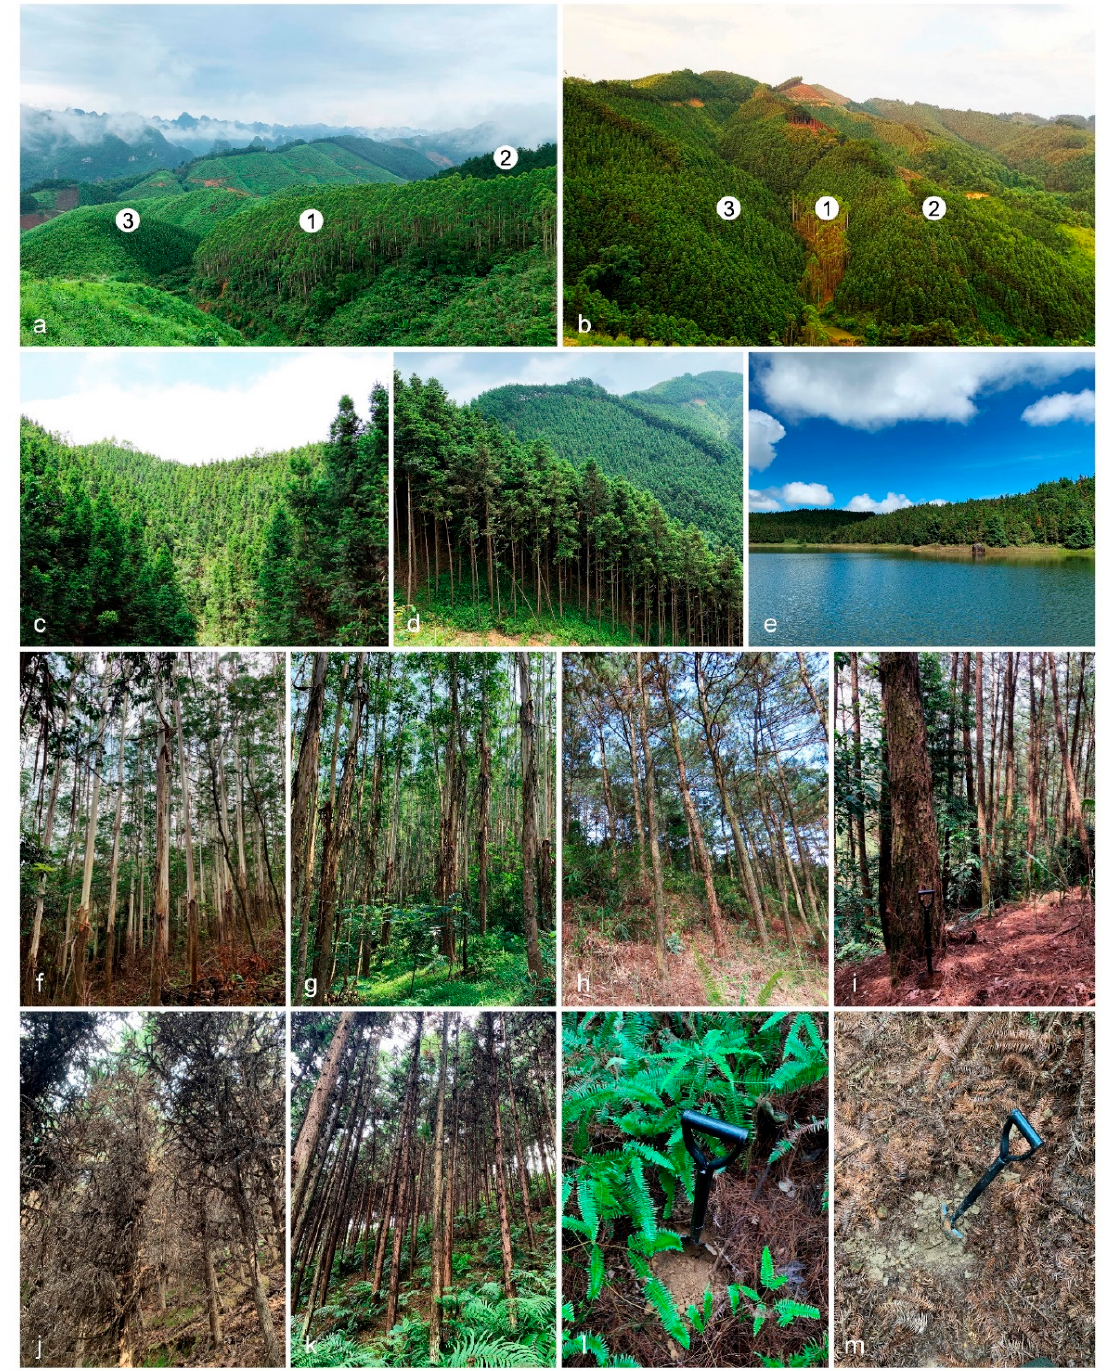
Figure 1. Plantations of Eucalyptus urophylla × E . grandis , Pinus massoniana , and Cunninghamia lanceolata in Fujian, Guangdong, Guangxi, and Yunnan Provinces in southern China. ( a , b ). The adjacently planted E . urophylla × E . grandis (indicated by number “1”), P . massoniana (number “2”), and C . lanceolata (number “3”) in Guangxi; c – e . Cunninghamia lanceolata plantations in Guangdong ( c ), Guangxi ( d ), and Yunnan ( e ); ( f , g ). Eucalyptus urophylla × E. grandis plantations in Fujian ( f ) and Guangdong ( g ); ( h , i ). Pinus massoniana plantations in Fujian ( h ) and Guangxi ( i ); ( j , k ). Cunninghamia lanceolata plantations in Fujian ( j ) and Guangxi ( k ); ( l ). Soil in P . massoniana plantation in Guangxi; ( m ). Soil in C . lanceolata plantation in FuJian.